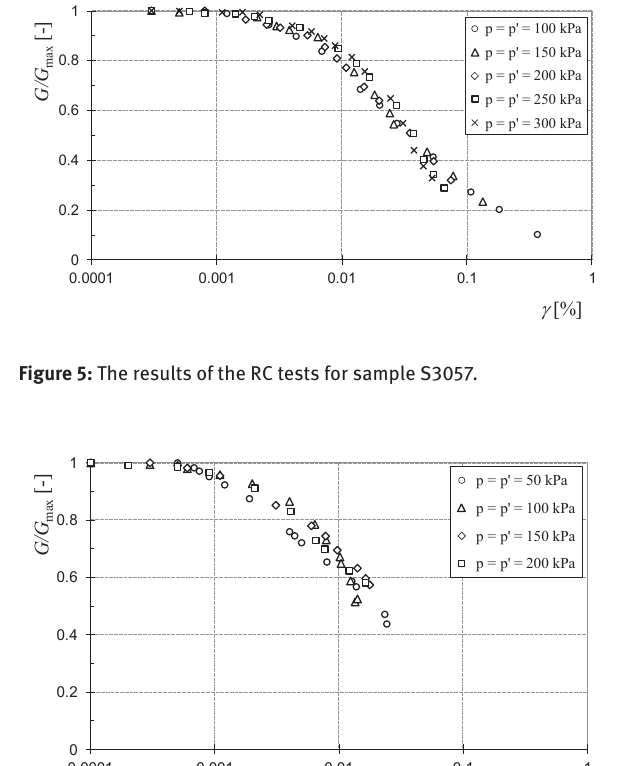
Figure 9: The results of the TS test of sample Fig. 9. The results of the TS test of sample S3935. Fig. 9. The results of the TS test of sample S3935. Analysing the differential equation describing the TS-based research [19]: